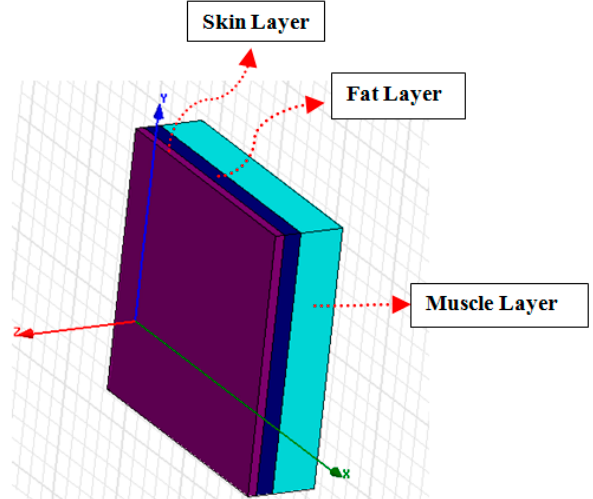
Figure 22. Three-layer human body biological model.